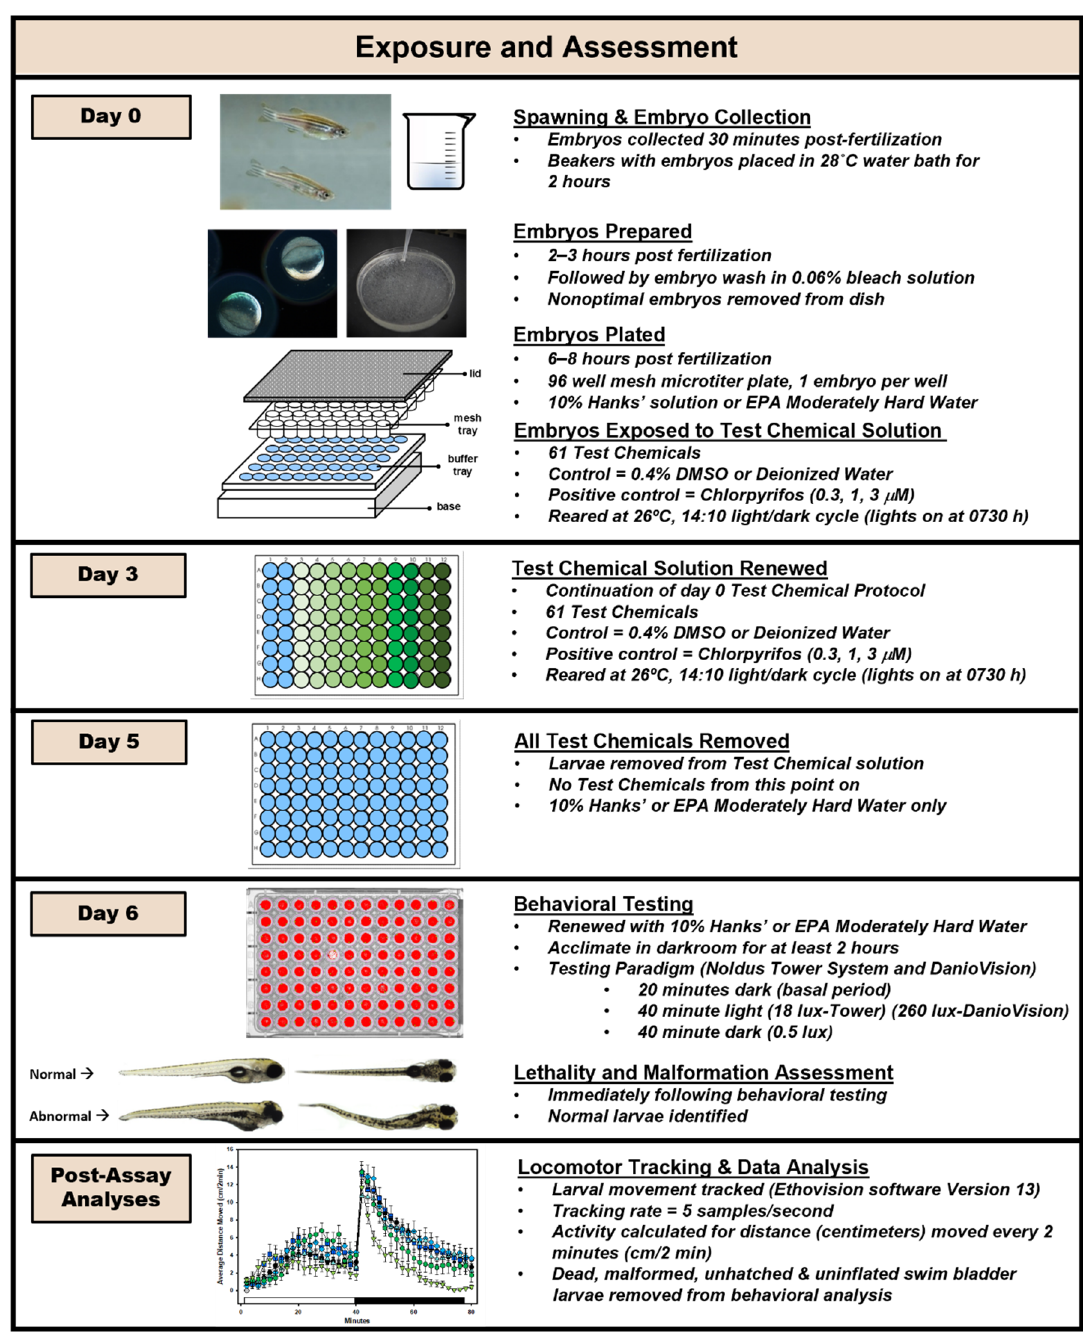
Figure 1. Experimental Design . Detailed timeline of the experimental process from spawning to analyses. The diagram is divided into sections for each critical time period, then further subdivided for event.